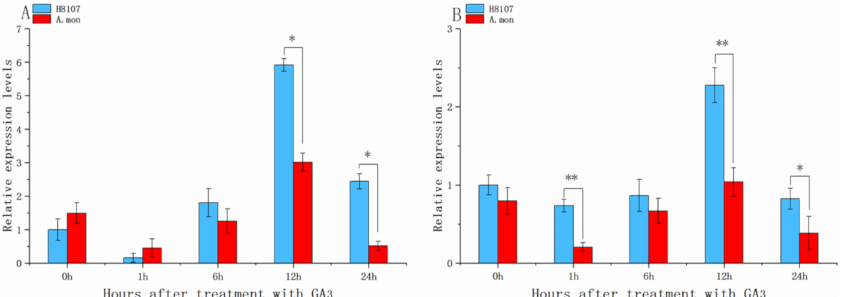
Figure 6. Expression analysis of AhGRF genes in response to treatment with the hormone GA3. qRT-PCR analysis of AhGRF transcript levels was performed on 2-week-old seedlings treated with GA3-0 h, GA3-1 h, GA3-6 h, GA3-12 h, GA3-24 h. ( A ) AhGRF 5a and ( B ) AhGRF 5b. Experiments were repeated three times and vertical bars indicate standard errors. * and ** represent significant di ff erences at p < 0.05 and p < 0.01,